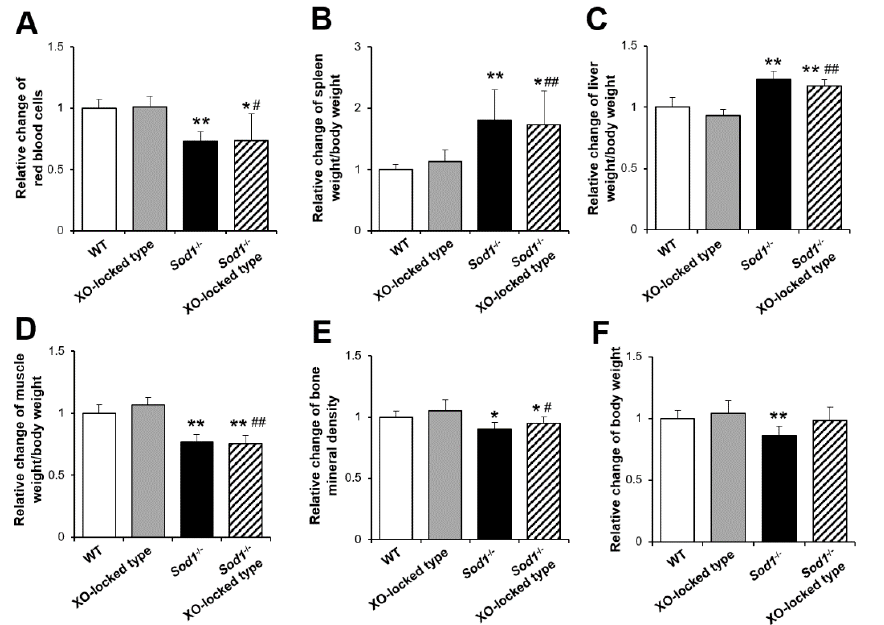
Figure 1. A phenotypical analysis of Sod1 , xanthine oxidase (XO)-locked-type double-mutant mice. Relative changes in the red blood cell count ( A ), ratio of spleen weight/body weight ( B ), ratio of liver weight/body weight ( C ), ratio of muscle weight/body weight ( D ), bone mineral density ( E ), and body weight ( F ) of wild-type (WT), Sod1 − / − , XO-locked - type, and Sod1 − / − XO-locked-type male and female mice (4–5 months of age, n = 5–6). * p < 0.05, ** p < 0.01 vs WT. # p < 0.05, ## p < 0.01 vs XO-locked type. Data are shown as the mean ± SD.